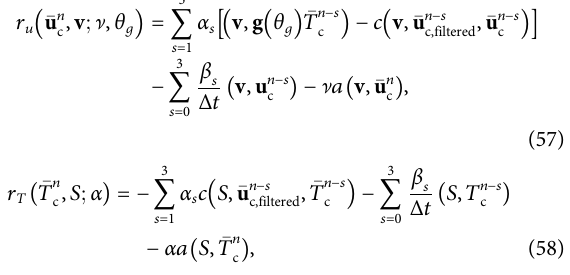
Algorithm 1 for the construction of the G-ROM, C-ROM and LDF-ROM for the pMOR. The algorithm starts with θ g, 1 * (cid:1) 0